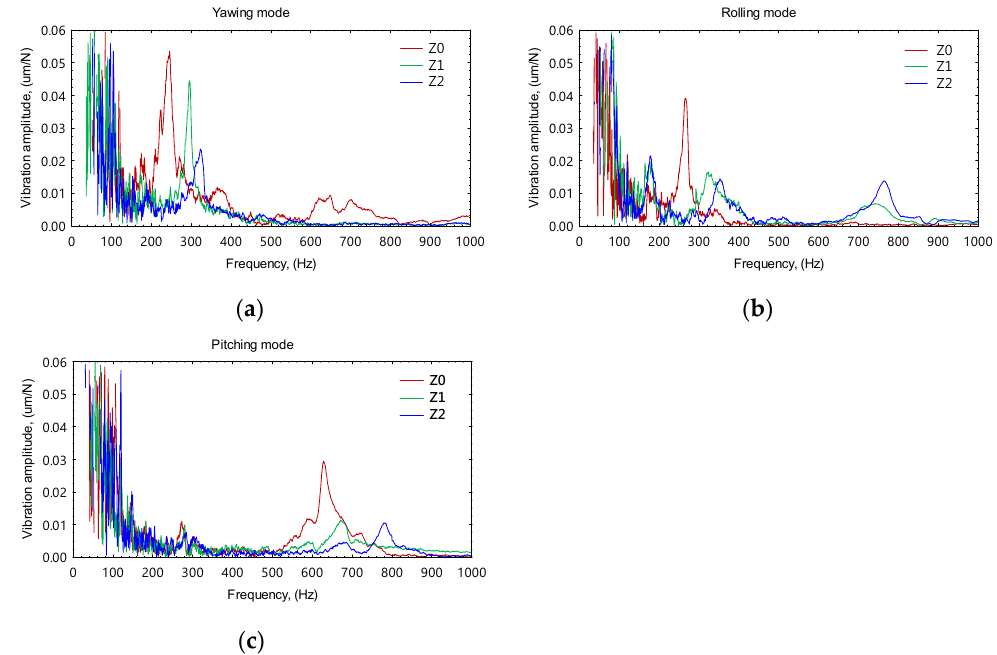
Figure 8. Frequency responses of the stage with different preloads: ( a ) yawing mode; ( b ) rolling mode; and ( c ) pitching mode.